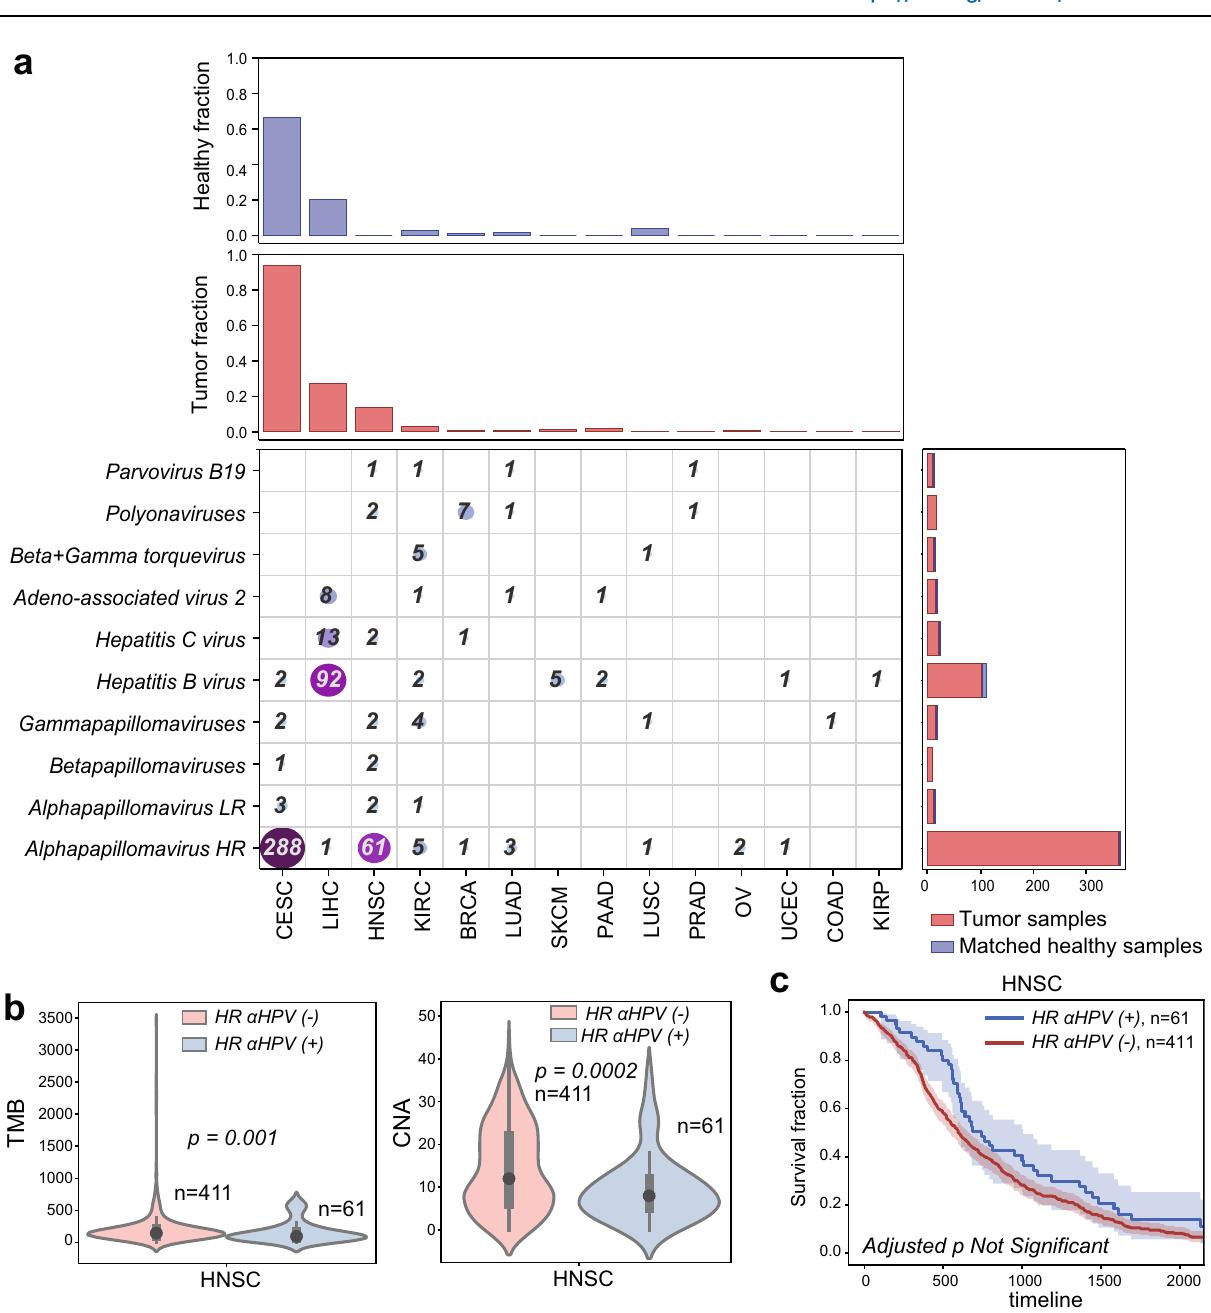
the boundaries of the violin plots refer to the maximum and minimum values, respectively. Two-sided Wilcoxon rank-sum p value is reported. c Kaplan – Meier curves comparing the survival rates between HNSC patients where the expression of high-risk alpha papillomaviruses was detected (blue curve) vs those where the expression of high-risk alpha papillomaviruses was not detected (red curve). The FDR-adjustedtwo-sidedlog-rank p valueisnotsigni fi cant(SupplementaryTable1). For Kaplan – Meier curves, shaded areas represent the con fi dence interval of sur- vival. Source data are provided as a Source Data fi le